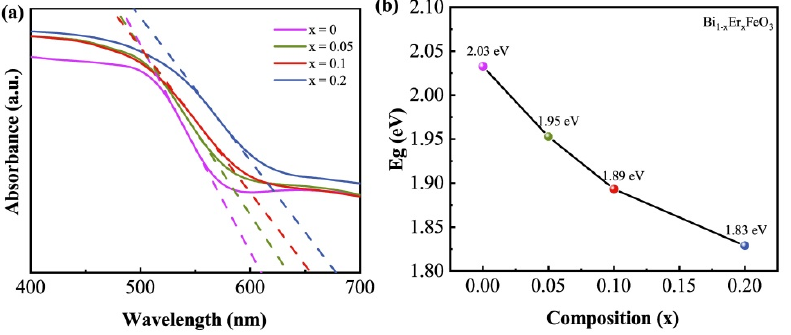
Figure 3. ( a ) Absorption spectra of Bi 1 − x Er x FeO 3 nanoparticles. ( b ) Band gap energy ( E g ) as a function of Er-doping content.